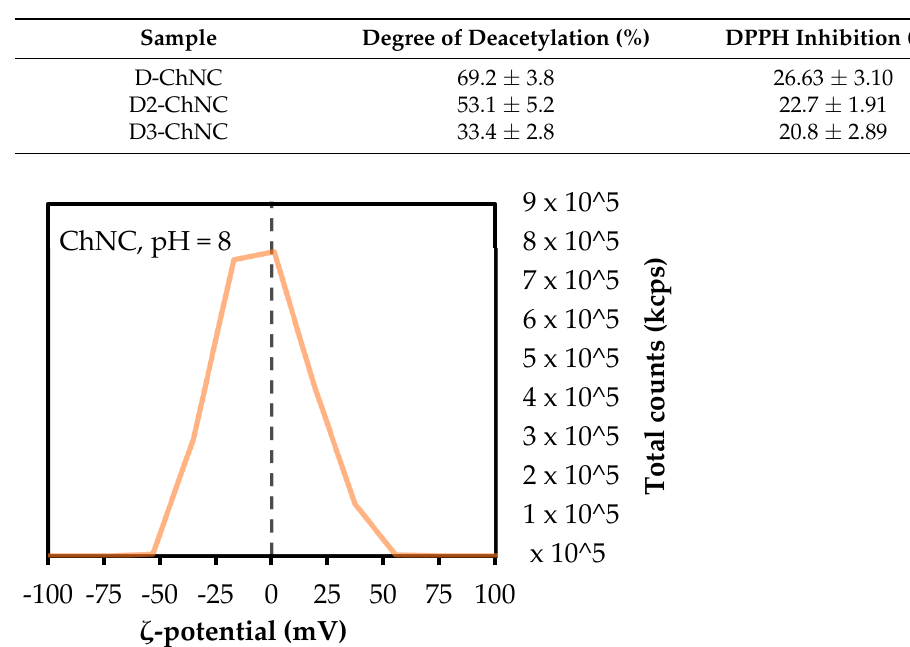
Figure A3. The calibration curve of NAG that was used to calculate the degree of acetylation. References 1.